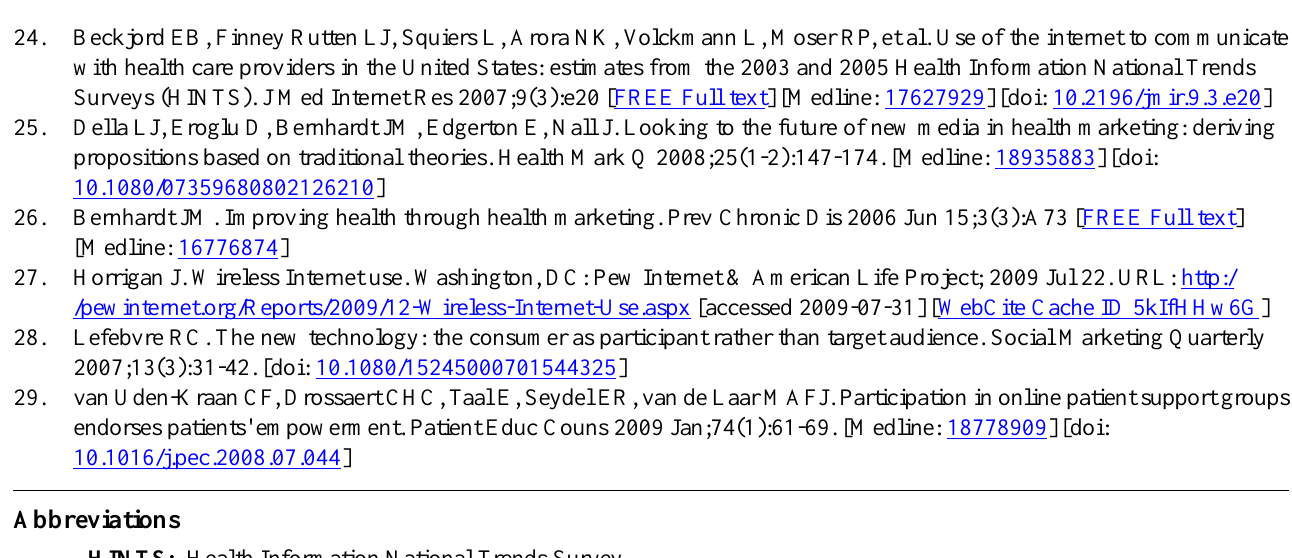
HINTS: Health Information National Trends